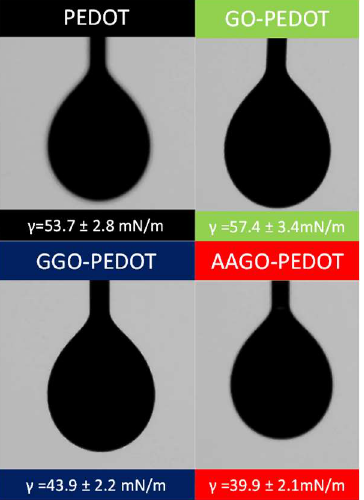
Figure 5. Optical pictures of surface tension measurements of pristine PEDOT, GO-PEDOT, GGO- PEDOT, AAGO-PEDOT and their droplet images.